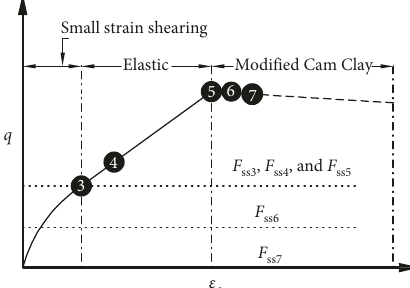
Figure 4: Changes of small strain yield surface during loading on denotes small strain yield surface the Modified Cam Clay. F ss i position at point i , where i �